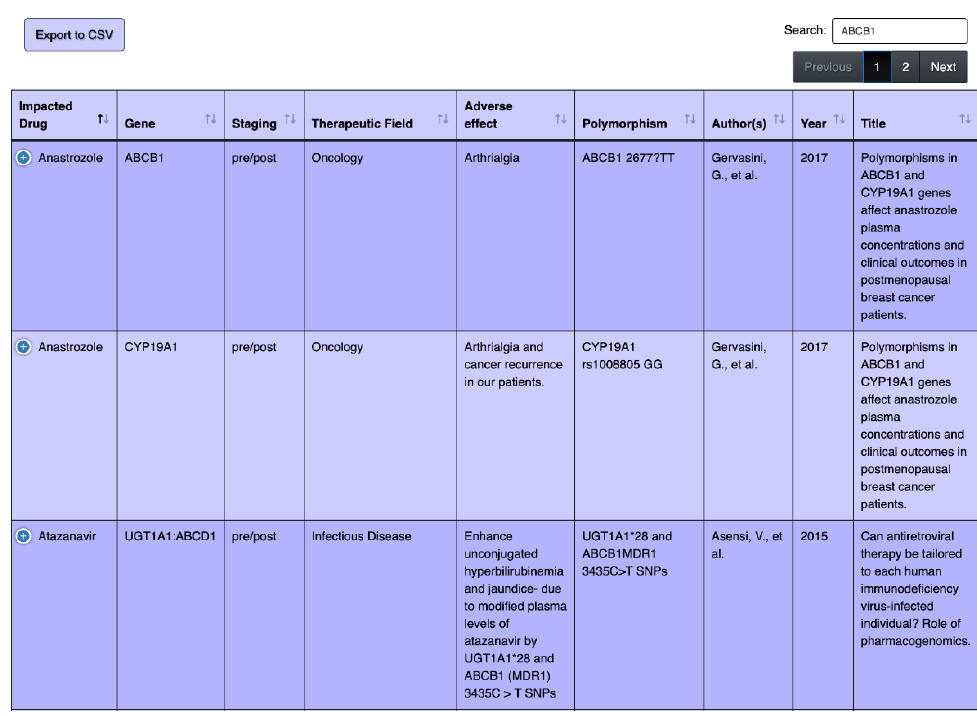
Figure 4. Screenshots of the web-based search tool of pharmacogenetics table, searching for drugs that have adverse effects on the ABCB1 gene. The background color is the same as the actual website, color variation is for row separation purpose.